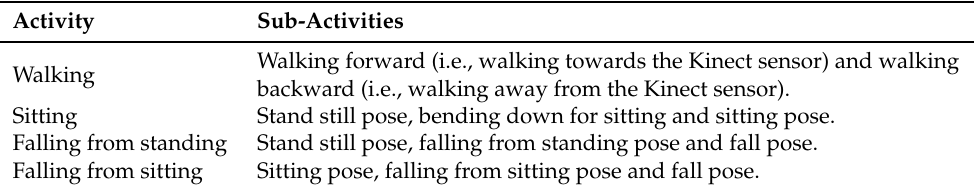
Table 1. The sub-activities encapsulated within each